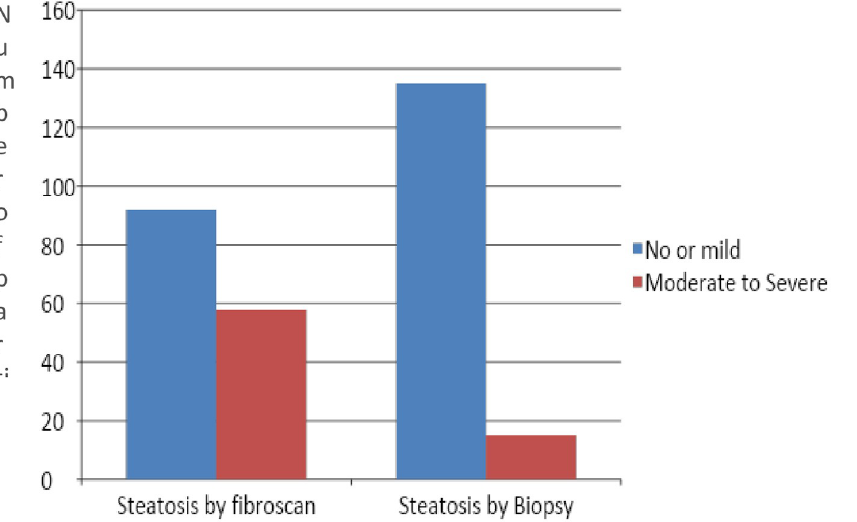
Fig 1. Steatosis as detected by Fibroscan and liver